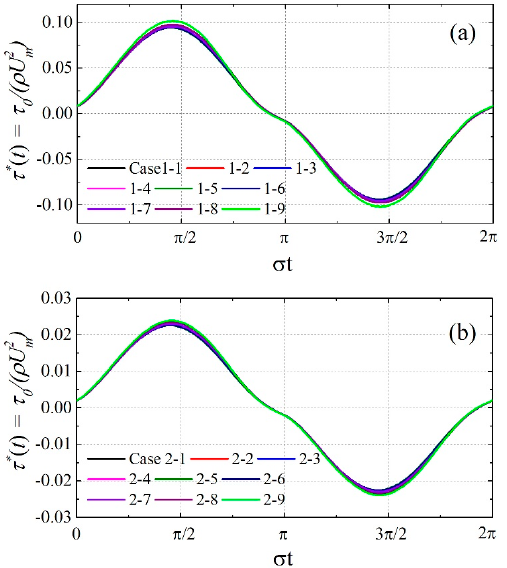
Figure 4. Time-variation of dimensionless bottom shear stress τ ∗ ( t ) . ( a ) Re = 3.51 × 10 6 , ( b ) Re = 1.99 × 10 7 .